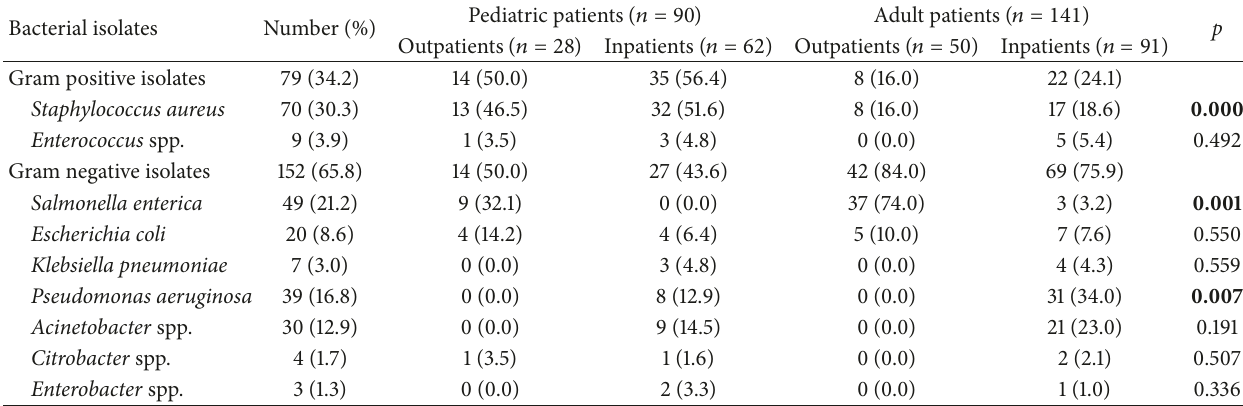
Table 2: Trends of bacterial isolates associated with bloodstream infections among pediatric and adult patients ( 𝑛 = 231 ). Bacterial isolates